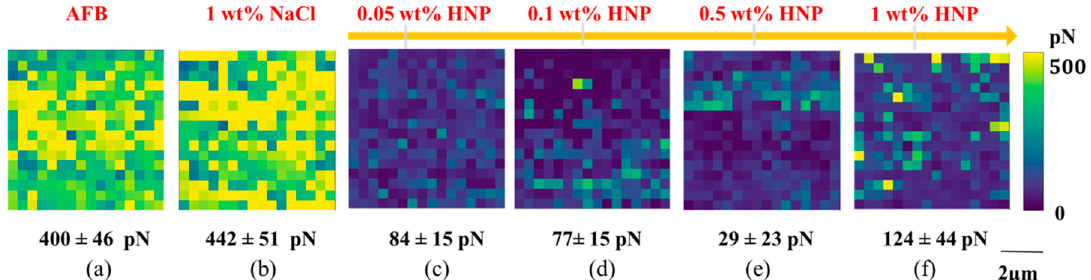
Figure 8. Force volume maps collected over a 5 µ m × 5 µ m scan area characterizing adhesion of non-polar -CH 3 groups to mica substrates in brine solutions. ( a ) AFB and ( b ) 1 wt% NaCl ( a , b ) and nanofluid solutions; ( c ) 0.05 wt%; ( d ) 0.1 wt%; ( e ) 0.5 wt%; ( f ) 1 wt% HNP. AFB is a formation brine formulation while 1 wt% NaCl is dispersant for the nanoparticles. The average adhesion force beneath the 16 × 16 pixel maps is based on 256 force curve measurements. An increase in nanoparticle concentration led to a decrease in adhesion force, although it appears that there is an optimum concentration of nanofluids for nanoscale wettability alteration, which in this case might be 0.5 wt% HNP.